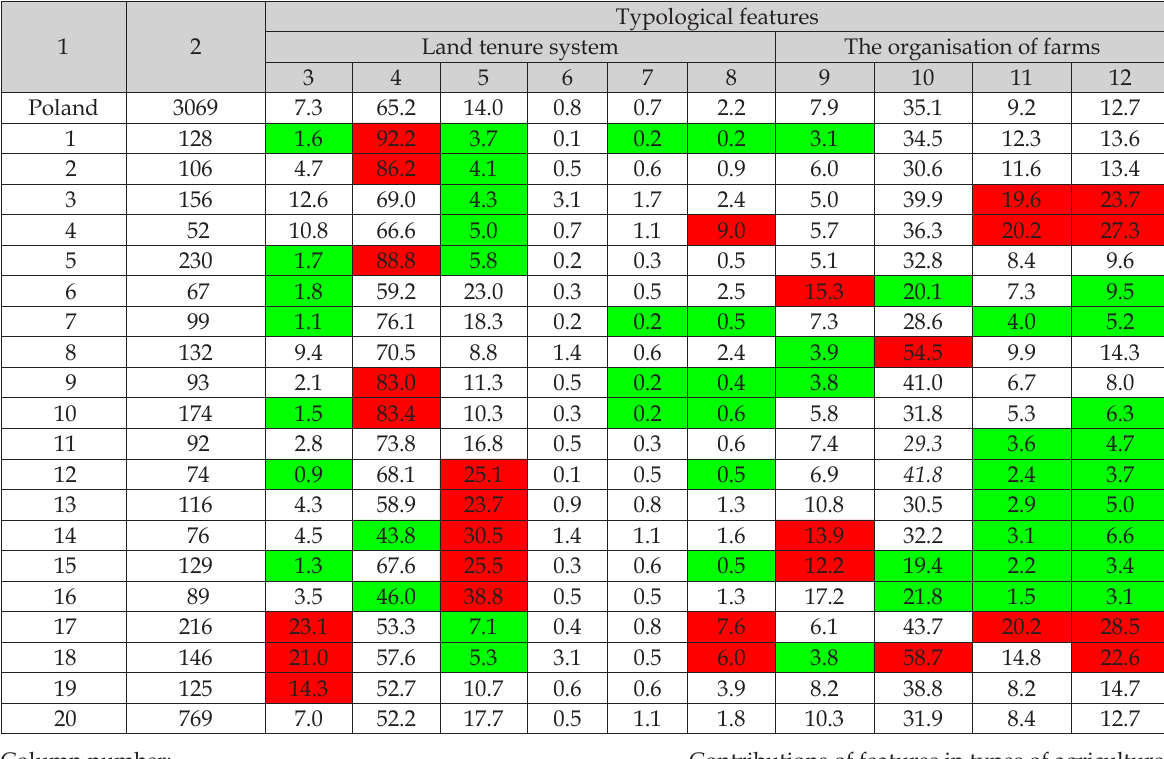
Table 1. Land tenure system (2012) and the organisation of the production space